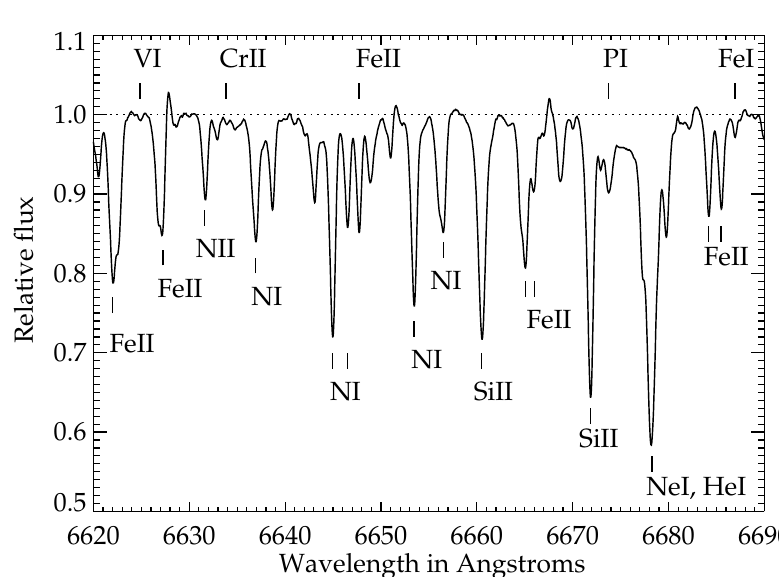
Fig. 1. A section of the red spectrum of υ Sgr with some identi(cid:12)ed lines shown. Even in this relatively mildly blended region several lines are considerably blended. tra. Full integration including nonidentified minor blends gave EW = 0 : 46 ˚A for 777.1 nm line and EW = 1 : 25 ˚A for full triplet. This correponds to M V = (cid:0) 5 : 73 and M V = (cid:0) 5 : 95 respectively using the calibration of Arellano Ferro et al. (2003). stars with normal chemical